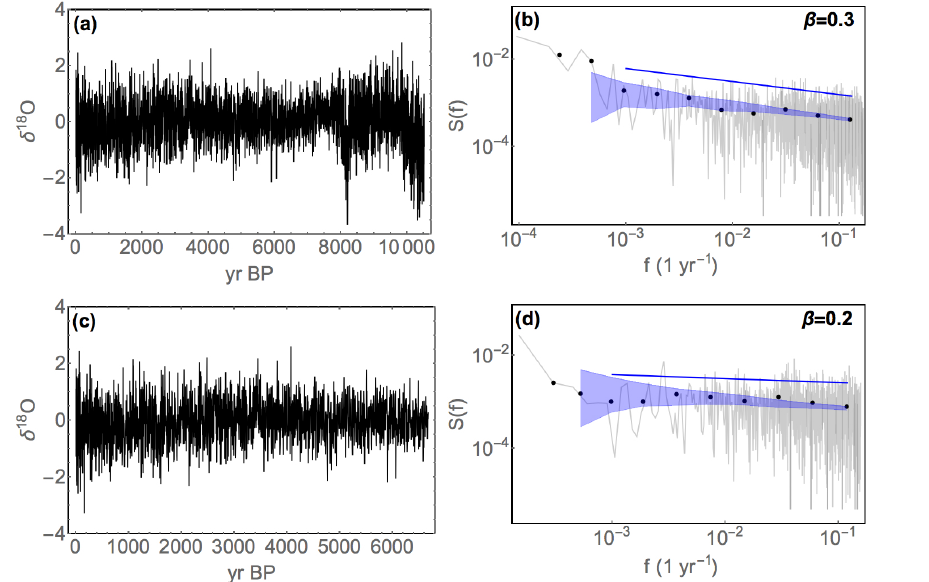
Figure 10. (a) δ 18 O anomalies from the Holocene part of the high-resolution GRIP ice core. (b) Periodogram. The raw periodogram is shown in grey, the log-binned version by black dots. β is estimated from the log-binned periodogram in the region marked by the blue line. The confidence range is shown by the blue, shaded area, estimated from a Monte Carlo ensemble of synthetic fGn’s with the estimated value of β and variance from the log-binned periodogram. (c) Same figure as in (a) except the oldest section has been removed. (d) Periodogram for the time series in (c) .